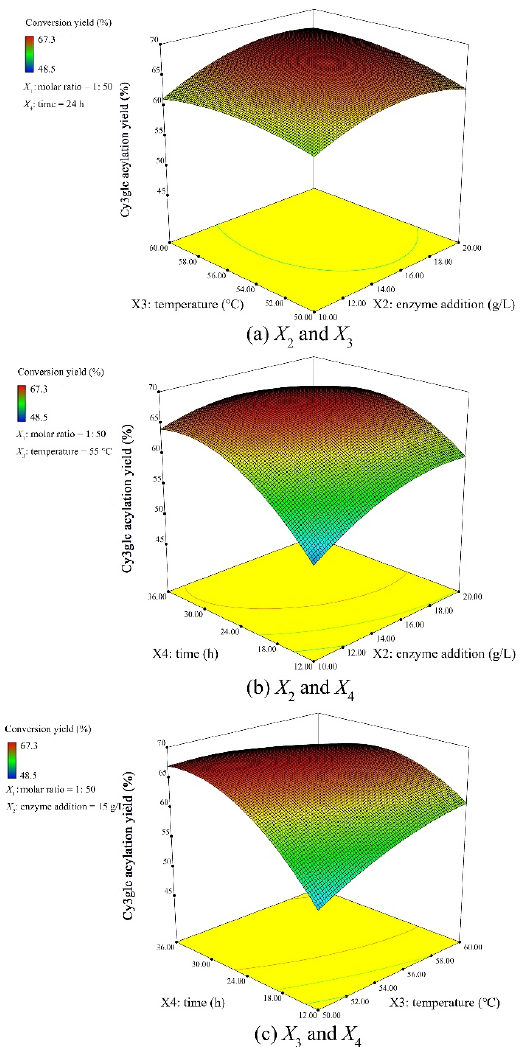
Figure 1. Response surface plots of the interactions between independent variables ( a ) enzyme addition X 2 and temperature X 3 , ( b ) enzyme addition X 2 and time X 4 , and ( c ) temperature X 3 and time X 4 on Cy3glc acylation yield